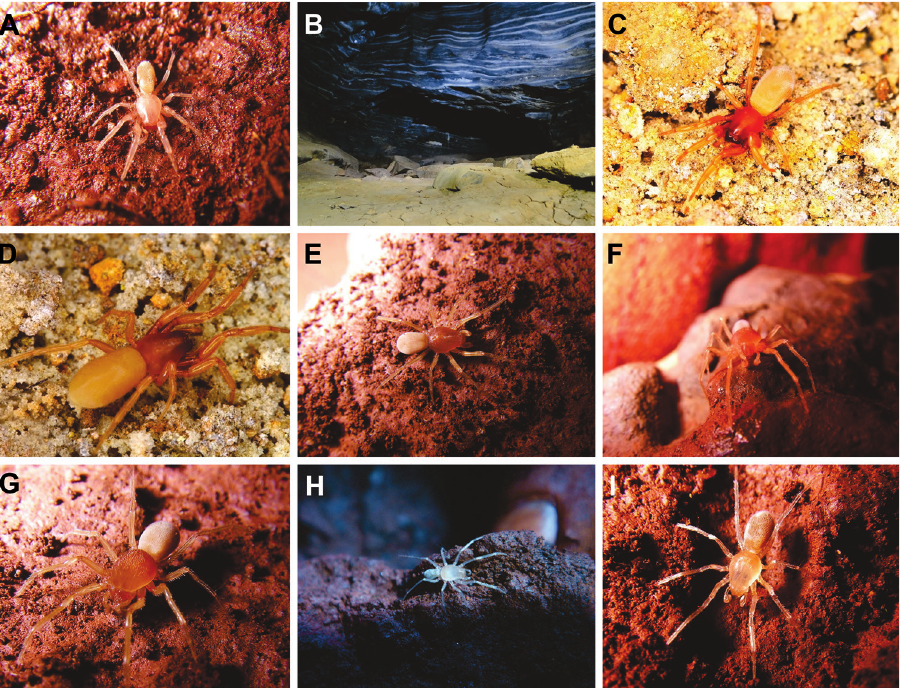
Figure 17. Tisentnops mineiro sp. n. ( A ), Tisentnops onix sp. n. ( B–D ), Carajas paraua sp. n. ( E–I ). A adult female on the soil B Gruta da Taboa, Minas Gerais, Brazil, showing the rocks on the soil where specimens of T. onix sp. n. were collected C adult female on the soil D same E adult female on rock F adult male on rock G adult female on rock H immature on rock I